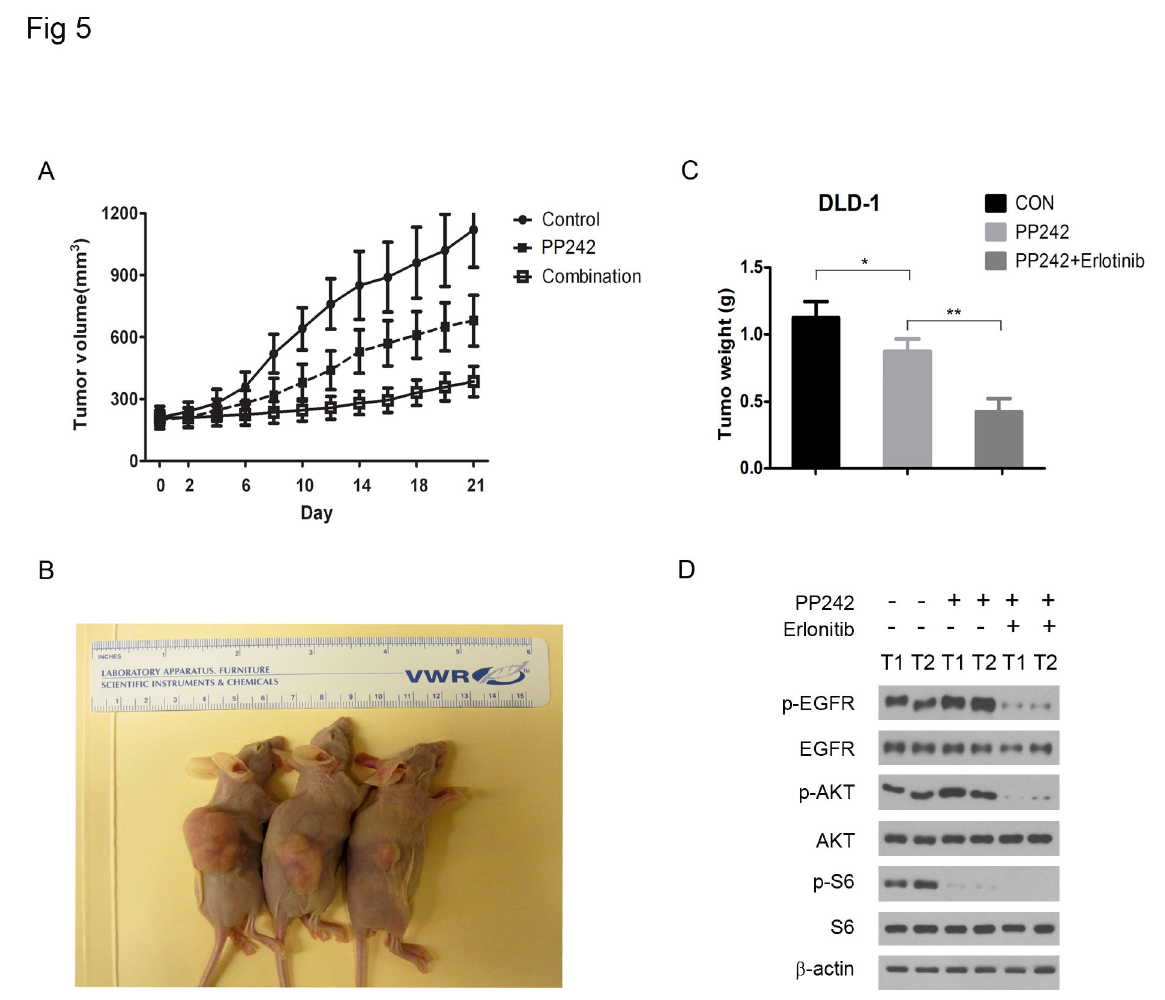
Figure 5. PP242 and erlotinib treatment suppresses xenograft progression in mice. (A) DLD-1 cells were injected subcutaneously in mice for xenograft formation and then treated with oral gavage of saline in control group of mice, PP242 in monotherapy, and PP242 plus erlotinib in combination treatment for the indicated days. The tumor volumes from the same group mice were grouped and presented as mean + SD. (B) At necropsy, the representative mice bearing subcutaneous xenografts were shown from the left to the right with PP242 and erlotinib combination, PP242 alone and saline. (C) The xenografts were dissected from mice and their weights were presented mean + SD. *, p < 0.05; **, p < 0.01. (D) The xenografts were lysed and subjected to western blotting for the presence of phosphorylated and unphosphorylated proteins in the xenograft tissues. doi: